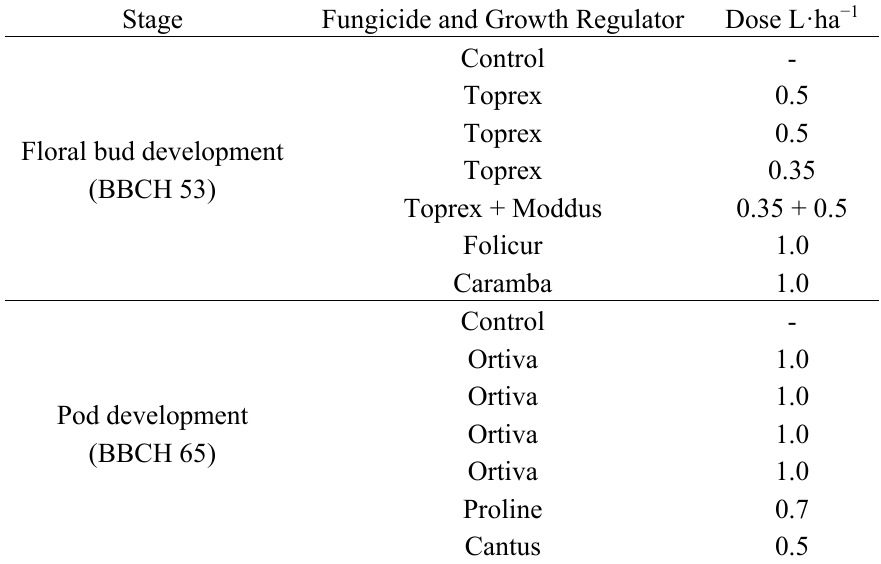
Table 1. Various fungicide and growth regulator applications at two developmental